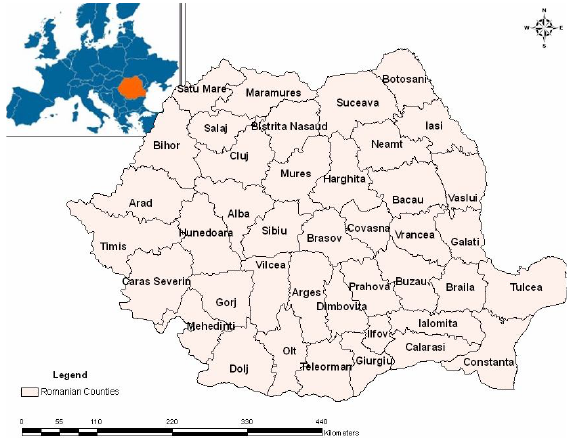
Fig. 1. Distribution of Romanian Counties. Figure 1. Distribution of Romanian Counties. 3